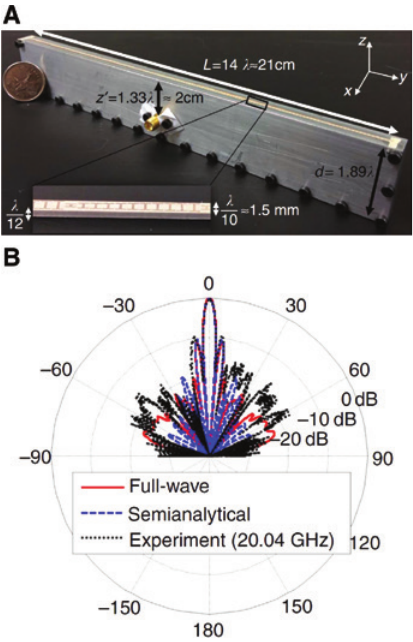
Figure 13: Cavity excited HMS antenna. Obtained from Ref. (53). (A) Photograph of the physical metasurface antenna. (B) Analytical, fullwave, and measured gain pattern of the metasurface antenna.